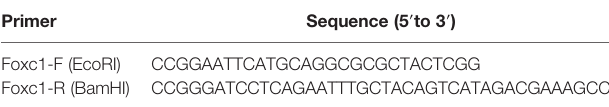
TABLE 6 | Real-Time PCR primer sequences for target genes (MC3T3-E1).